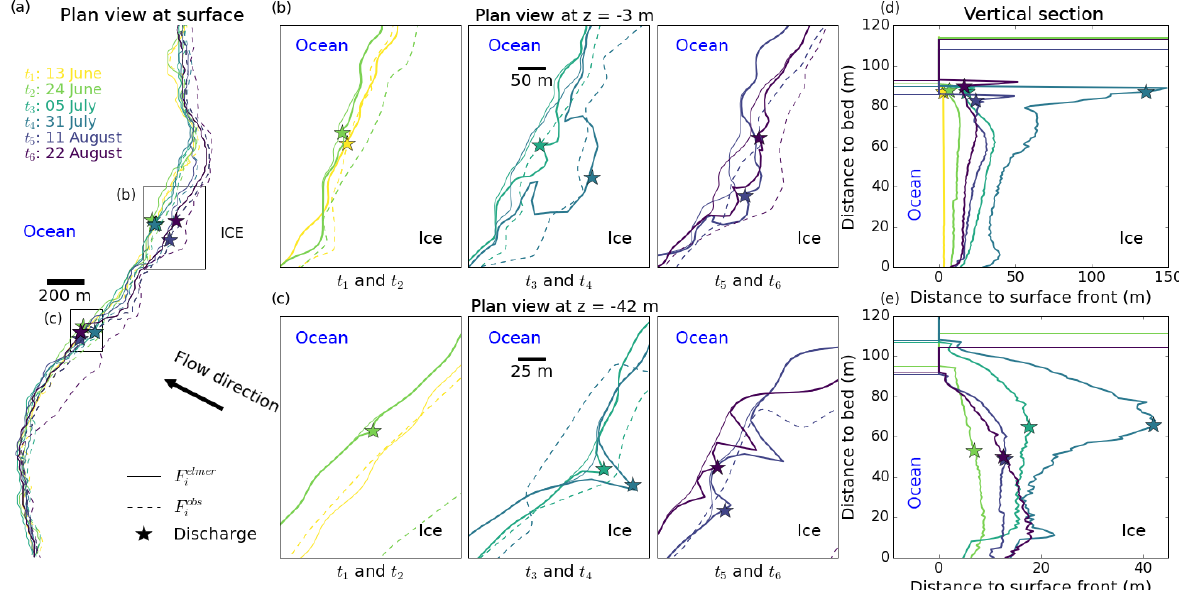
Figure 8. (a) Plan view of the observed frontal position of Kronebreen at six different dates, defined by different colours, corresponding to the satellite data acquisition dates during the melt season in 2013 (up to 22 August). At t i , the observed front, F obs (z = 0 ) , by a thin line. The discharge location is defined by a star. Enlargement at (b) the a dashed line and the advanced front, F elmer i northern discharge (ND) area at z = − 3m and at (c) the southern discharge (SD) area at z = − 42m with the advanced front at depth z (z) , represented by a thick line. Vertical section (d) at the northern discharge (ND) location where undercutting has been applied, F elmer i and at (e) the southern discharge (SD) location. The stars in (d, e) indicate the plan view elevation z from (b, c) . Horizontal lines in (d, e) represent the sea level for each